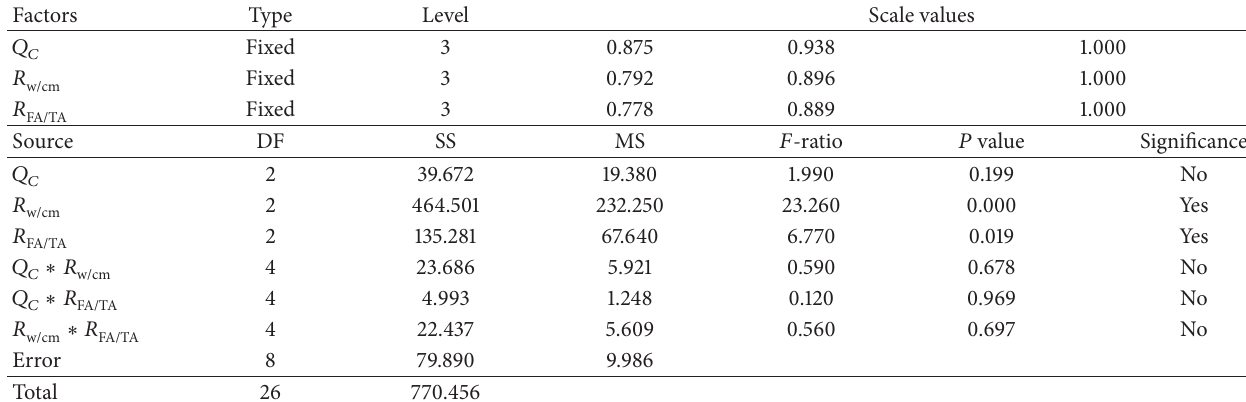
Table 5: ANOVA for compressive strength test